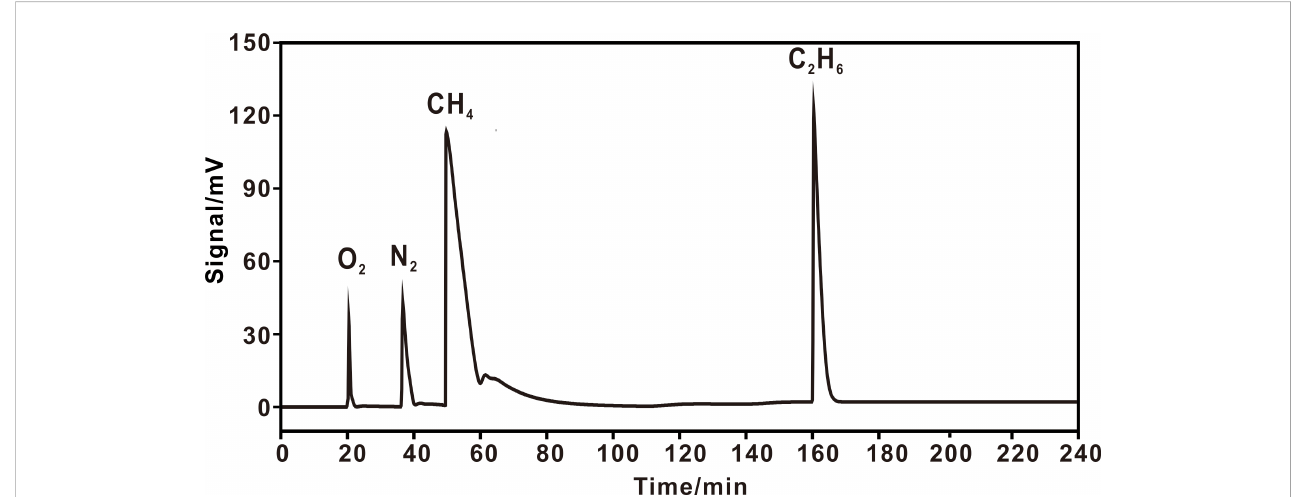
FIGURE 7 Chromatograms of air + C 1 – C 3 hydrocarbons on 6,2,1/8 columns. A heating procedure was adopted with an initial temperature of 25 °C (110 min), and heating at 10 °C min – 1 to 120 °C (20 min), then to 200 °C. C 3 H 8 didn ’ t appear within 240 min.